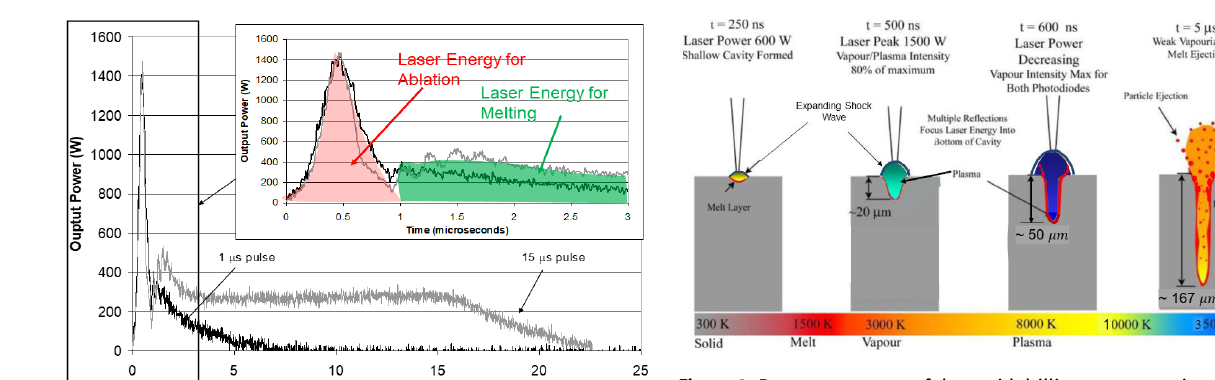
Figure 3: Process anatomy of the rapid drilling process using a one micro-second laser pulse generated by a single-mode CW fiber laser. This is an improved diagram from Tu et al. (2013).